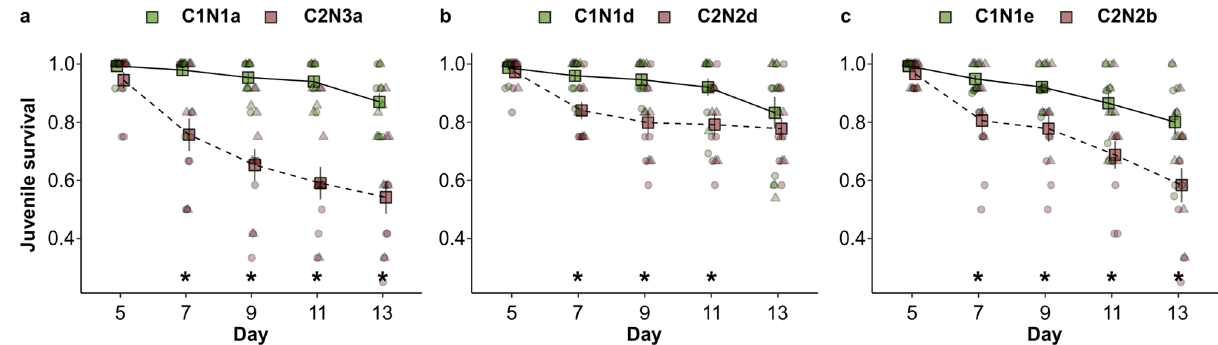
Fig. 5 Proportion of juvenile survival of Tetranychus urticae fi eld-derived lines on honeysuckle. The survival proportion of juveniles ( y -axes) from six iso- female lines representing common T. urticae genotypes found in the Dutch dunes was tested in three independent experiments ( a – c ). Honeysuckle- restricted lines C1N1a, C1N1d and C1N1e are coloured green and represented by a solid line; generalist lines C2N3a, C2N2d and C2N2b are coloured red and represented by a dashed line. Survival was scored across fi ve consecutive time points, spanning from egg hatching to adulthood (represented in days on the x-axes). Stars represent a signi fi cantly different survival mean for each time point ( α ≤ 0.05); error bars represent one SEM. n = 12 leaves for each genotype per panel, 6 from the top side of the leave (triangles) and 6 from the bottom side of the leave (circles). F -statistics and p -values are speci fi ed in Supplementary Table